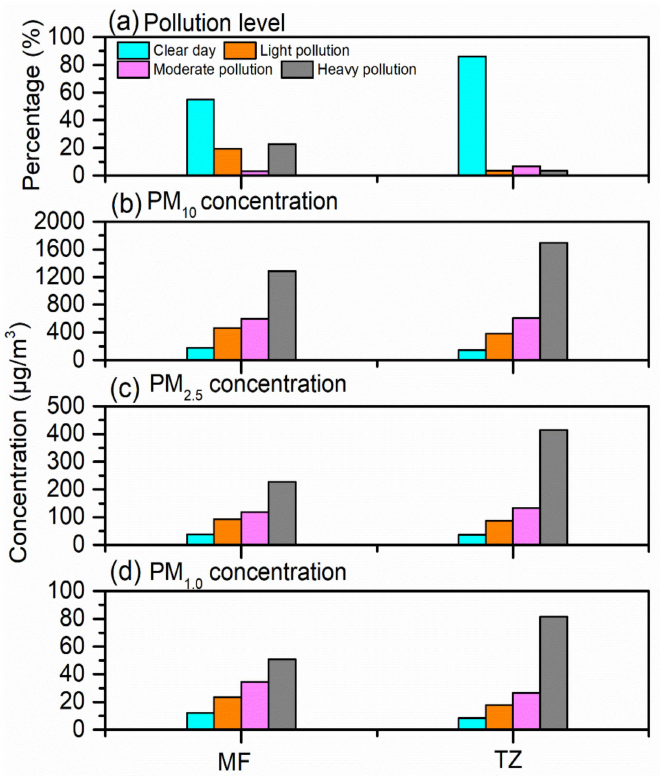
Figure 4. Comparison of the pollution level and concentration in MF and TZ during July 2021. ( a ) pollution level, ( b ) PM 10 , ( c ) PM 2.5 , ( d ) PM 1.0